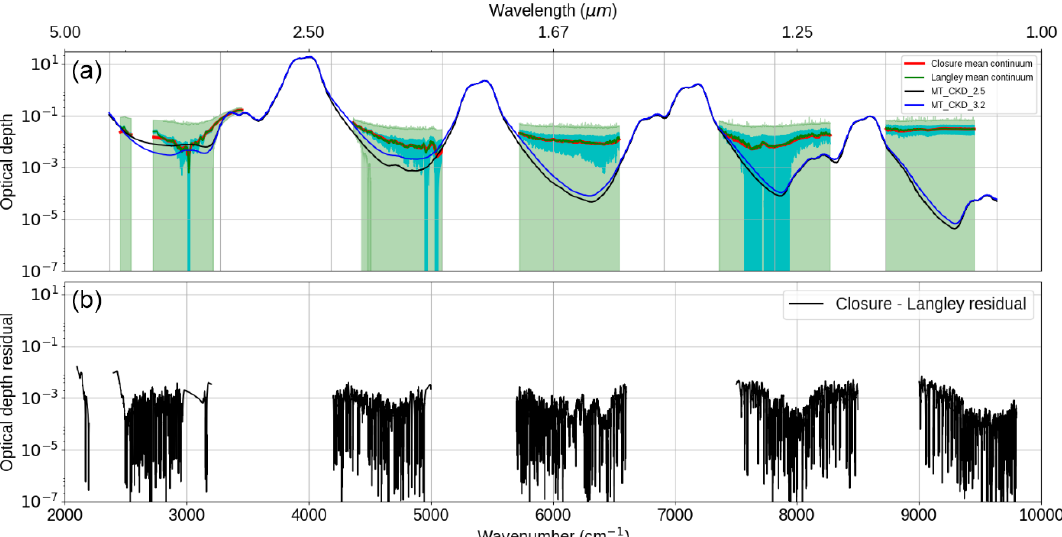
Figure 8. Comparison between the Langley and closure method derivations of the continuum optical depth on 18 September 2008. Panel (a) shows absolute values and panel (b) the residual of the two. Teal shaded region is the k = 1 Langley uncertainty, and green is the k = 1 closure uncertainty. The optical depth from two versions of MT_CKD is shown in panel (a) for comparison.